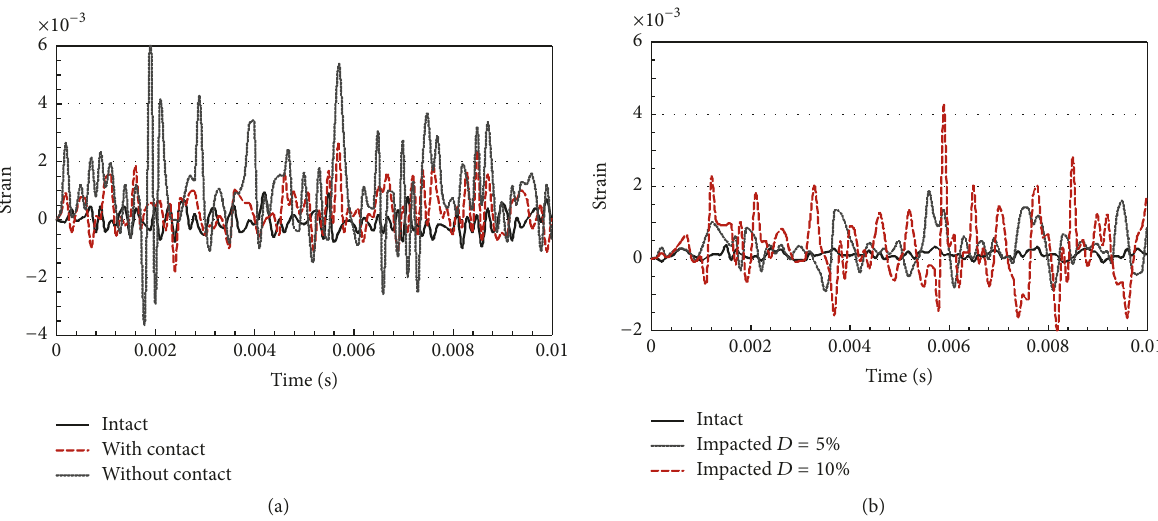
Figure 18: The influence of contact on longitudinal strain [73]: (a) models with and without contact and (b) models with different sizes of the debonded